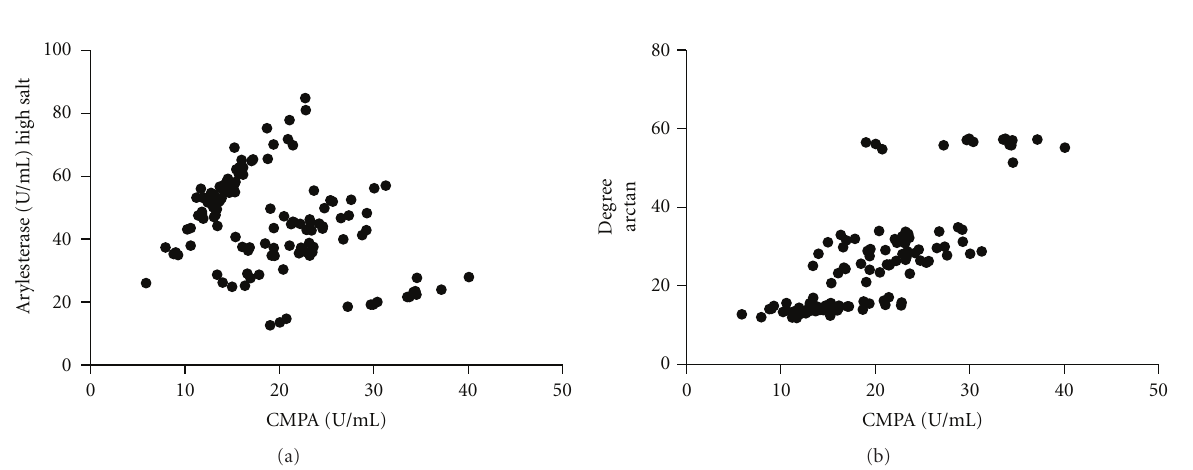
Figure 1: (a) Activity measured using phenyl acetate at high salt conditions versus CMPA. (b) Transformation of activities using arctangent ( x / y ) ∗ 180/3.14 versus CMPA. This transformation converts x and y coordinates into the angle in